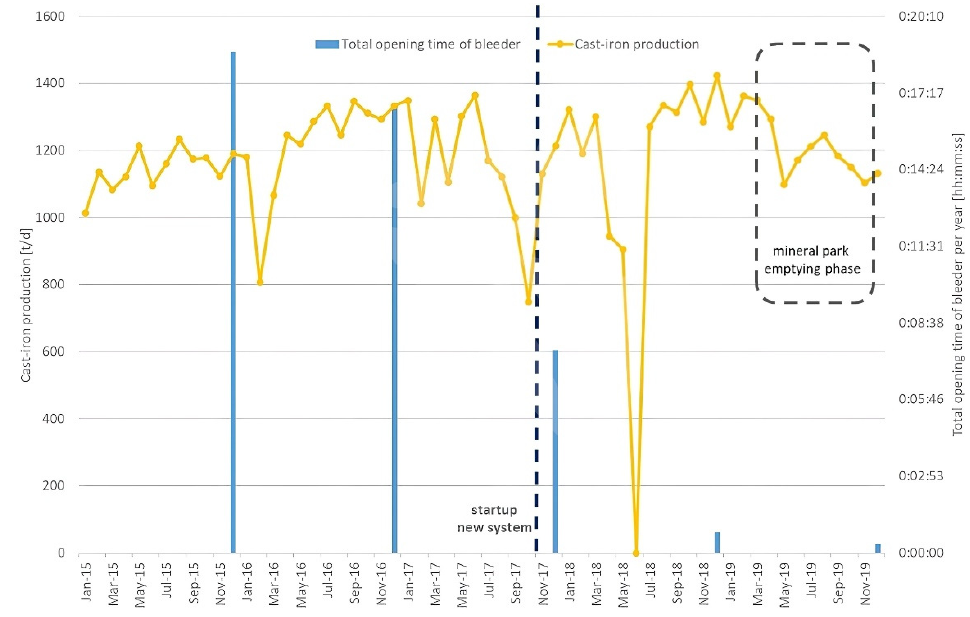
Figure 21. Production trend and total opening time of BF top bleeders in the same timeframe.